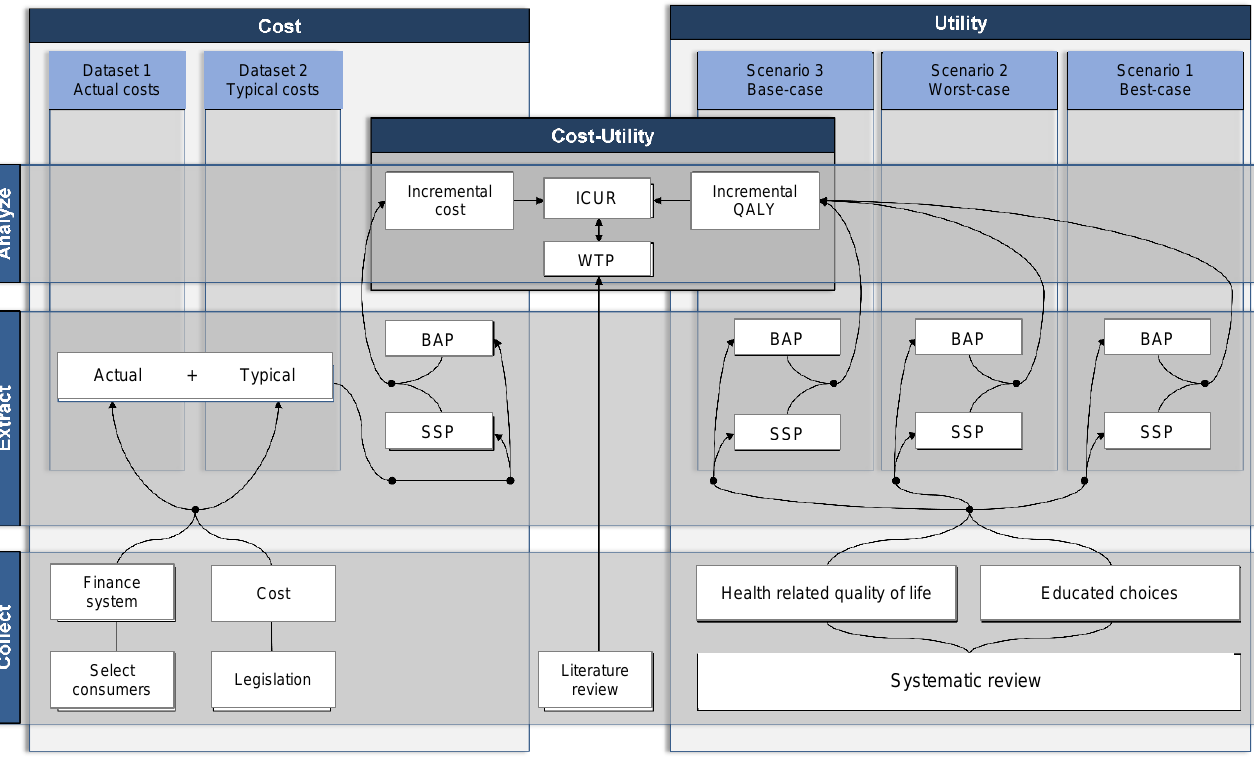
Figure 5: Overview of the approach applied to conduct preliminary cost-utility analyses (CUA) of transfemoral and transtibial bone-anchored (BAP) compared to socket-suspended (SSP) prostheses providing incremental cost-utility ratios (ICUR) based on incremental costs expressed in monetary units and utilities expressed in quality-adjusted life-years (QALY) that were compared to willingness-to-pay threshold (WTP) for small series of plausible scenarios (e.g., base-case, worst-case, best-case) over a six-year time horizon from Queensland Artificial Limb Service (QALS) prosthetic care perspective.